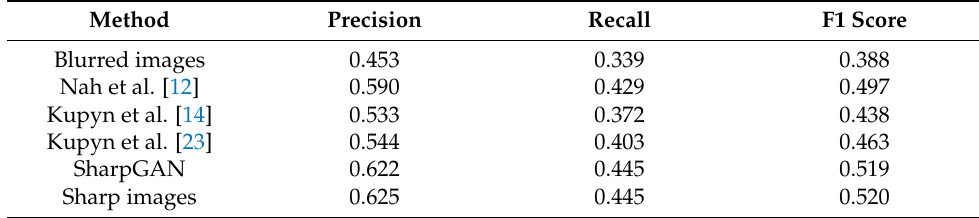
Table 4. Quantitative detection results of SMD